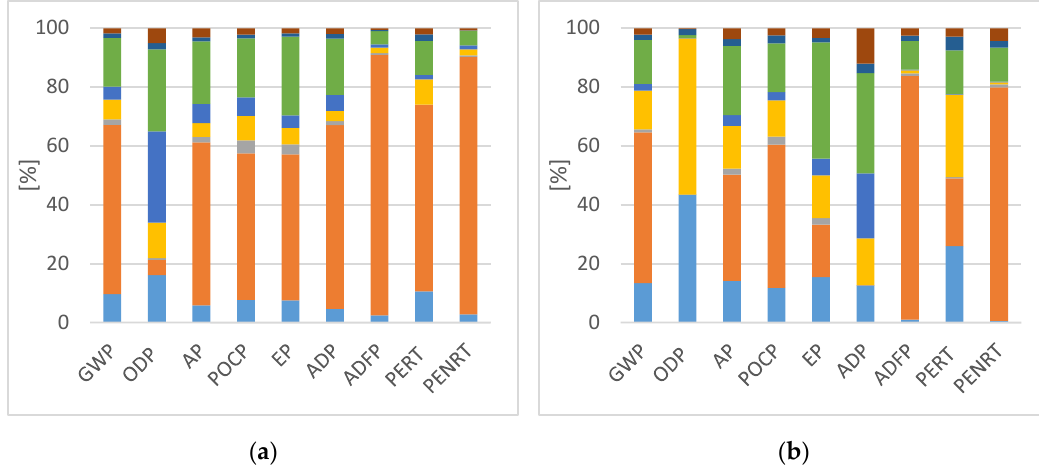
Figure 2. Environmental impact of complete ETICS system produced according to the National Technical Approval ITB-15-9090 in the year ( a ) 2012, and ( b ) 2017. The thickness of the EPS thermal insulation board: 10 cm. The data represent the sum of environmental impact from A1 to A2 stage of ETICS life cycle assessment. The data represent the mean value obtained from the analysis of different renderings, e.g., mineral render, acrylic render, silicone render, and silicone-silicate renders. Legend: ( ■ ) adhesive for bonding insulation, ( ■ ) insulation material, ( ■ ) glass fiber mesh, ( ■ ) adhesives for base coats, ( ■ ) key coats, ( ■ ) finishing coats, ( ■ ) primers, and ( ■ ) decorative coats.